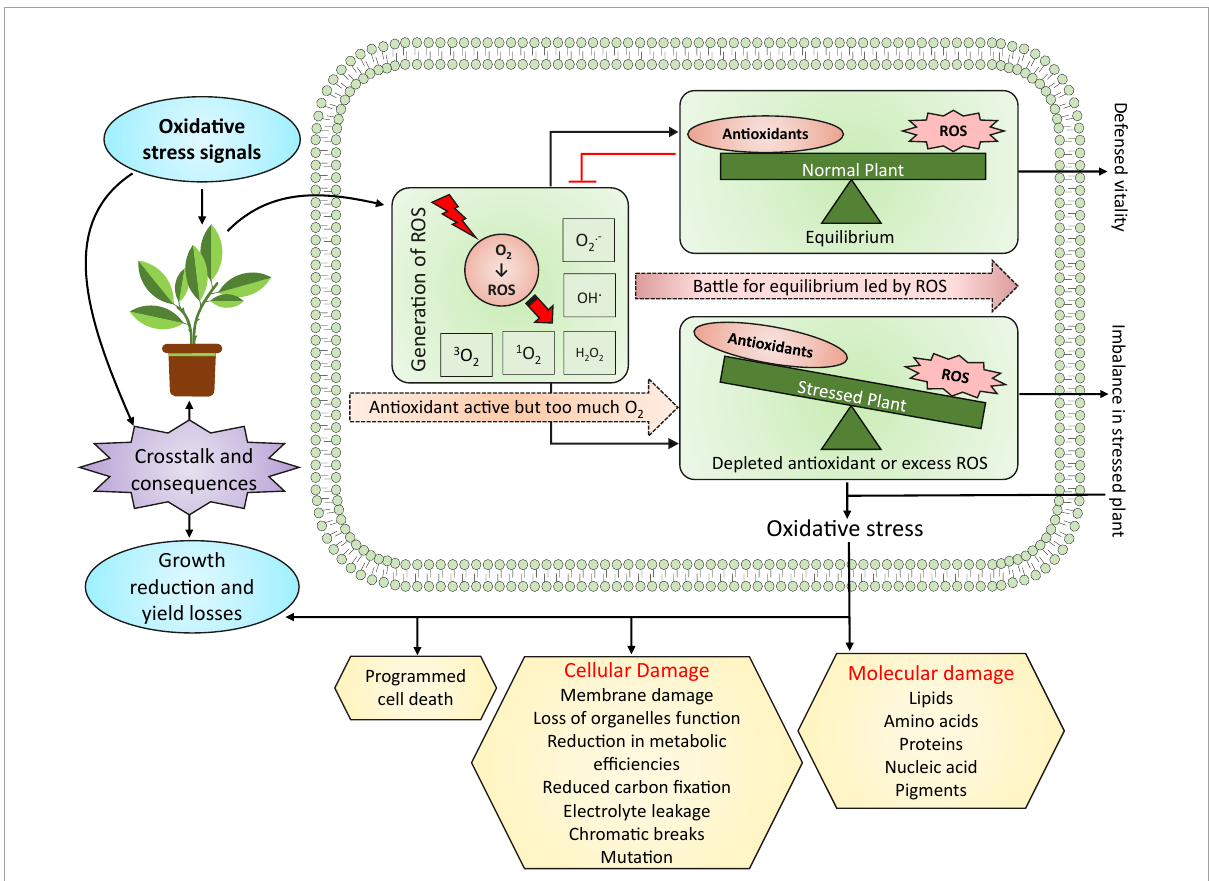
FIGURE3 Oxidative stress in plants and its significance. Under abiotic-stress-induced oxidative stress, ROS generation is the most significant step, which leads to the battle for equilibrium between ROS and antioxidant defense. This involves substantial crosstalk and consequences between stress signals and plant growth and yield reduction. For instance, minor damage caused by oxidative stress can improve growth and yield, whereas extreme oxidative stress can significantly reduce plant growth and yield—modified from Hasanuzzaman et al. (2020a). ROS, reactive oxygen species; H 2 O 2 , hydrogen peroxide; O 2 , oxygen; 1 O 2 , singlet oxygen; 3 O 2 , triplet oxygen; O •− 2 , superoxide; OH • , hydroxyl